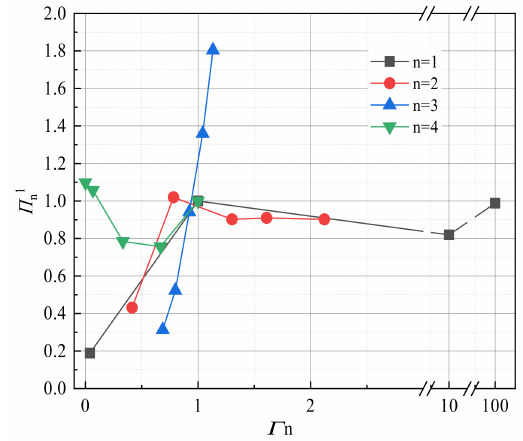
Figure 20. Sensitivity analysis of flue gas water recovery.